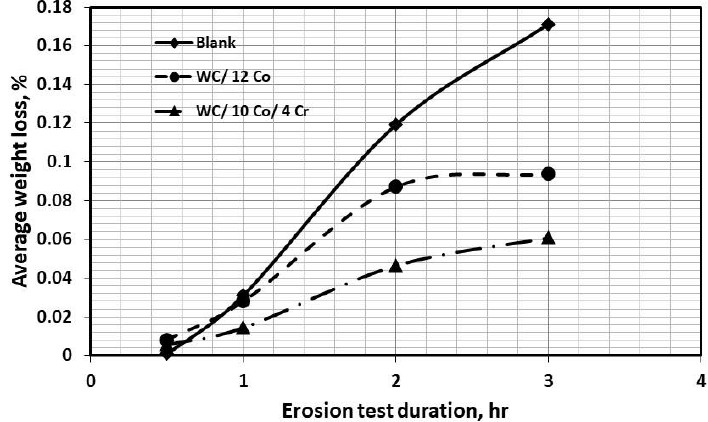
Figure 16. Erosion test results for both types of coating along with the bare substrate. Low-magnification SEM images were taken for the eroded surfaces resulting from slurry exposure times of 2 and 3 h testing in which considerable weight loss occurred as shown in Figure 17. The images of the surfaces in the shot blasted, WC-12Co and WC- 10Co-4Cr coated samples in their as-sprayed condition are shown in Figure 17, which is divided horizontally according to to sample type and vertically according to erosion test exposure duration. The first left column shows the samples before erosion test whereas the second and third columns show the same sample types after exposure to erosion test for 2 and 3 h respectively. Generally, the common feature of these samples is that rough surface topographies shown in the first column of Figure 17a,d,g have changed into a rel- atively smoother surface (dark-grey) through partially removing the surface peaks as shown in Figure 17b,e,h. Worth noting that the light-grey zones in the coated samples are valleys in which the erosive slurry did not effectively erode them during this specific time (i.e., 2 h). On the other hand, with longer exposure times (i.e., 3 h) as in Figure 17c,f,i, the effect of slurry was more erosive where more material at peaks was removed and more valleys were revealed (light-grey zones).